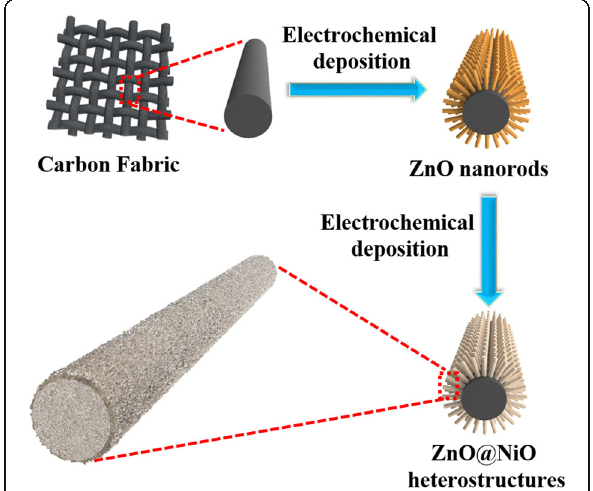
Fig. 1 Fabrication process of hierarchically ZnO@NiO